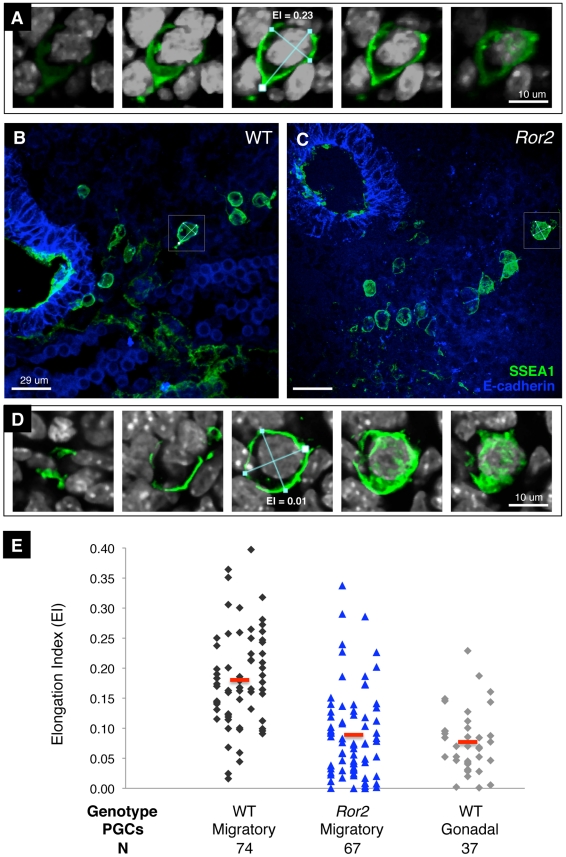
Reduced elongation of migratory Ror2Y324C PGCs in vivo.(A) WT migratory PGC stained with SSEA1 (green) and DAPI (grey) shown in five sections at different levels through a confocal stack. The axes are measured (blue lines) in the largest plane of the cell, shown in the middle panel, resulting in an EI = 0.23. (B) A confocal stack from a WT e10.25 embryo section stained with SSEA1 and E-cadherin to delineate the hindgut (left). Autofluorescent erythrocytes are present in the lower right quadrant. Filopodia and lamellopodia can be seen on many PGCs; the cell in (A) is boxed. (C) A similar histologic section from a Ror2Y324C embryo posterior, showing several SSEA1+ PGCs in the dorsal mesentery, many of which appear rounded. The boxed PGC is represented in (D), where measurement of the long and short axis in a plane yields an EI = 0.01. (E) Accumulated measurements for EIs of migratory WT and Ror2 mutant PGCs from e9.75–10.75 histologic sections. Postmigratory WT e10.75 (“Gonadal”) PGCs are shown at right in grey and the mean EI in red.